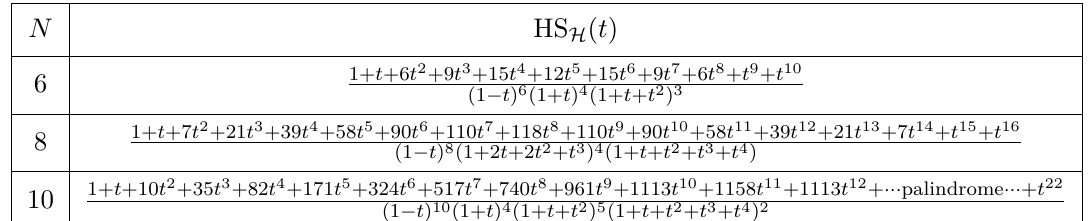
consistency check one could perform for N = 1 , by comparing the Higgs branch Hilbert v series. Note that in this limit, the non-simply-laced edge in (3.6) disappears and such a computation is accessible. Concretely, one has to compare the Molien-Weyl formula for the N = 2 r , N = 1 limit of v